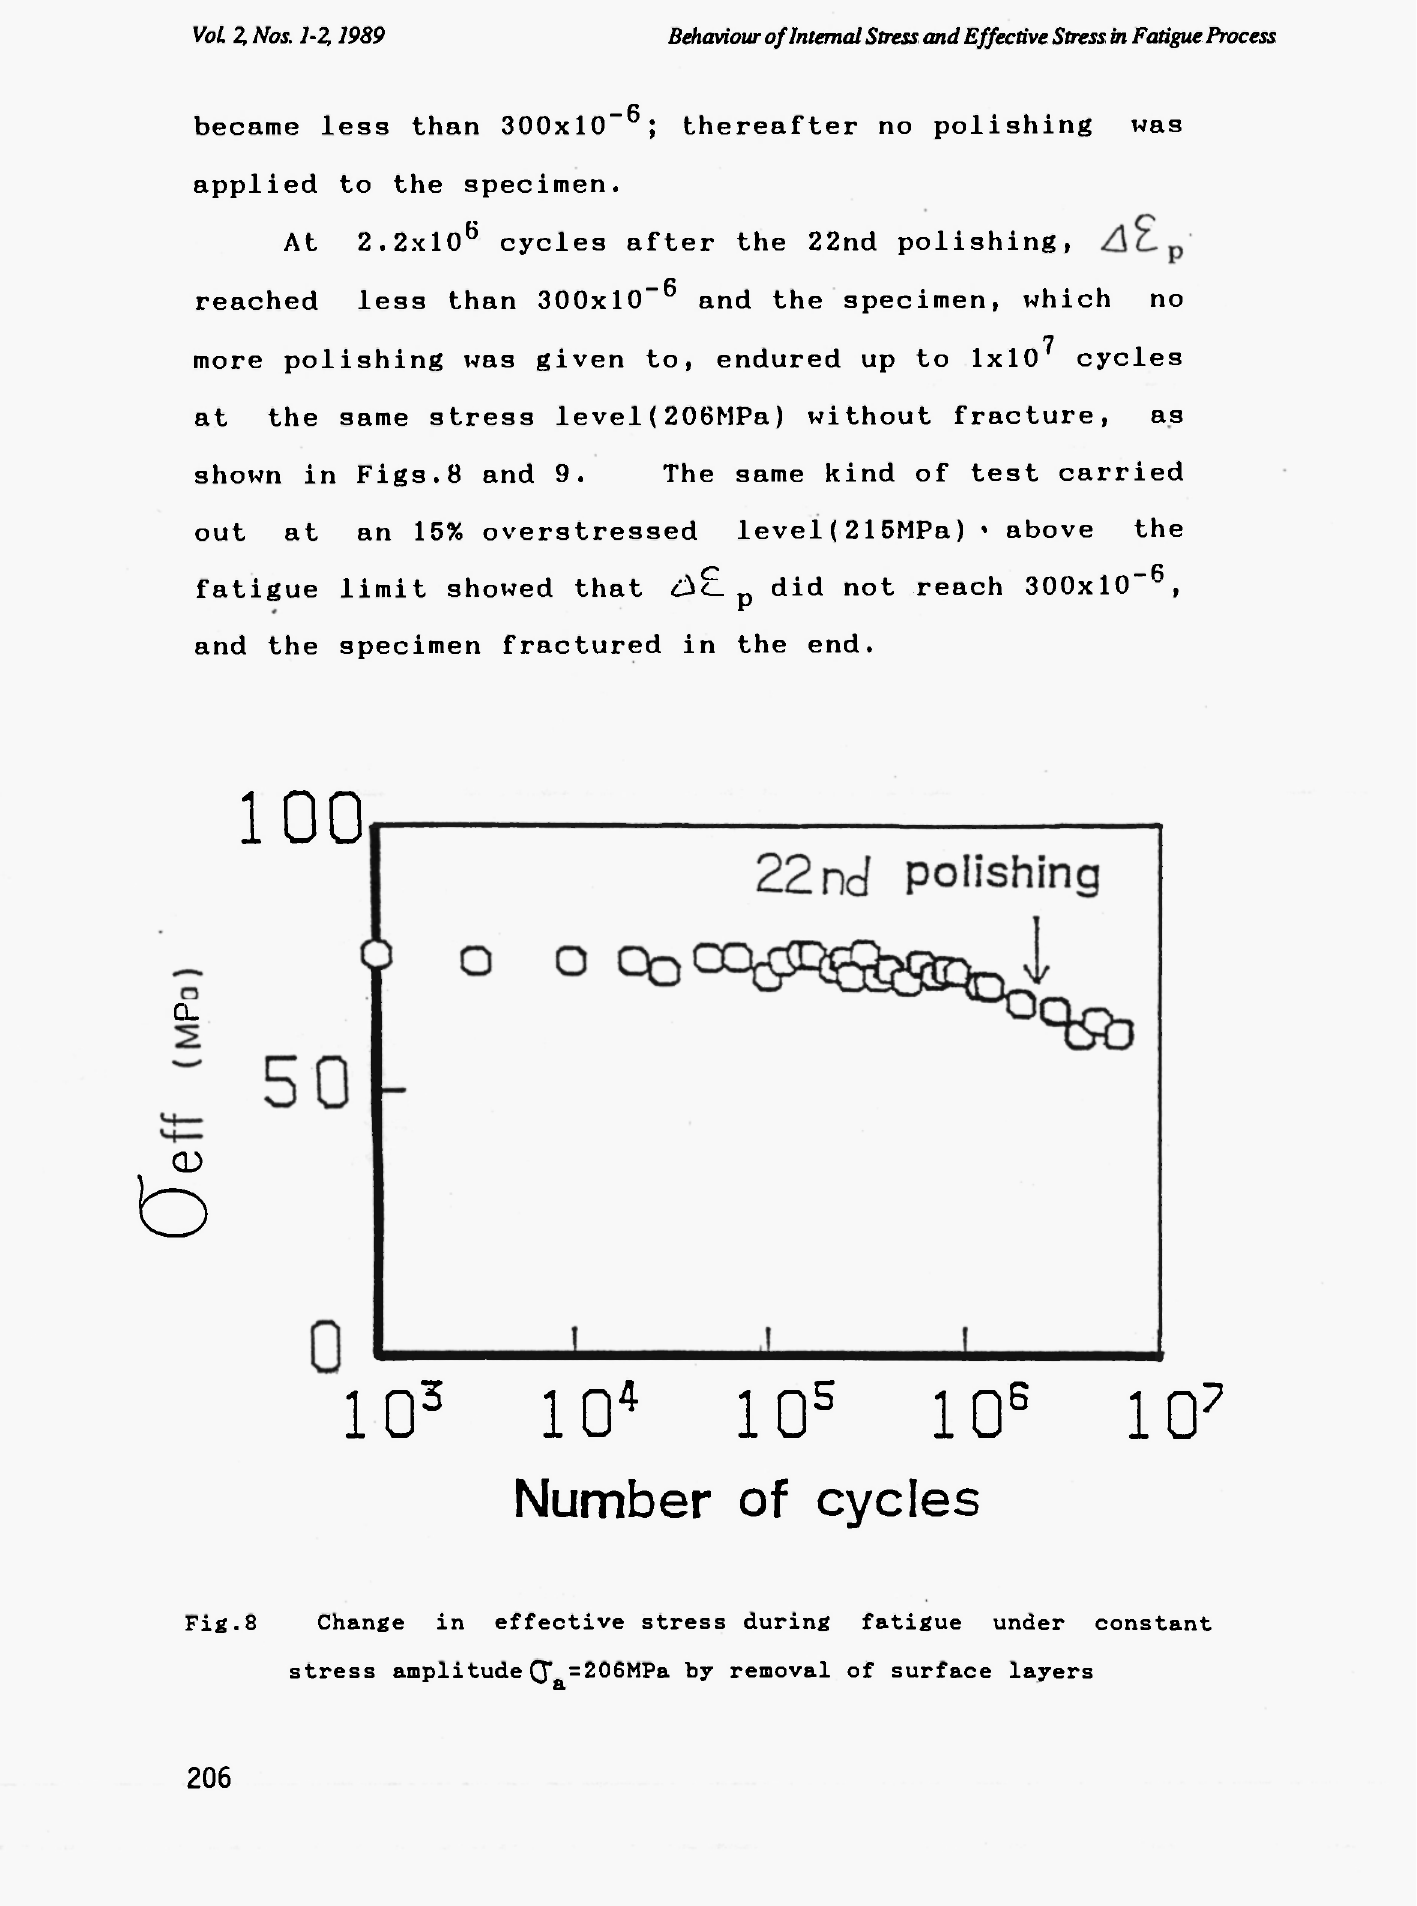
Fig.8 Change in effective stress during fatigue under constant stress amplitude Q" =206MPa by removal of surface layers